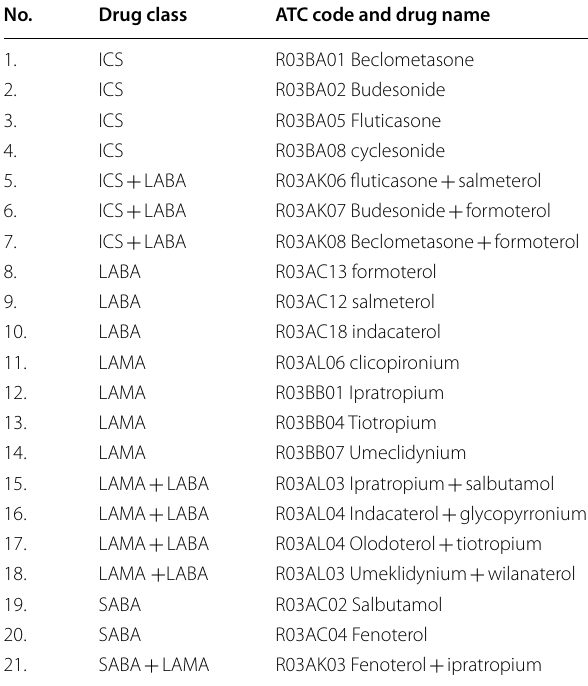
Table 2 Levels of primary non-adherence to inhaled medicines by gender, chi 2